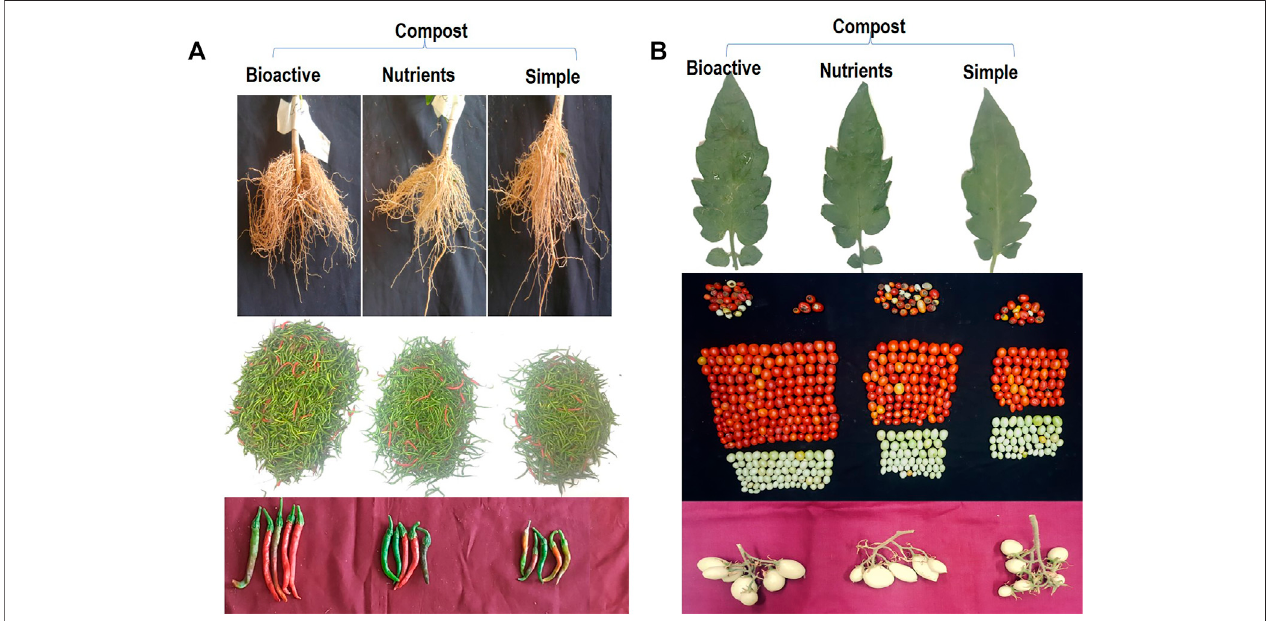
FIGURE 6 | Response of bioactivecompost on chilies ’ root growth, total yield per plot, and size of the chili (A) , and tomato leaf growth, yield per plot (one picking), and the in fl orescence (B) in microplots compared with other treatments.